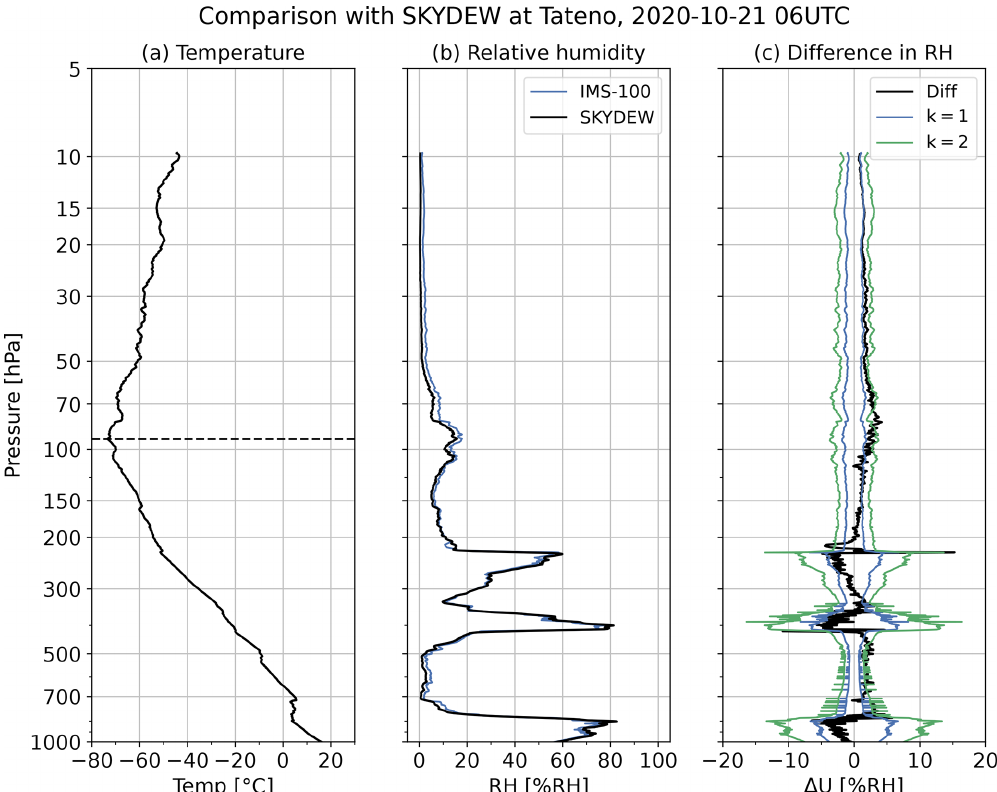
Figure 33. Comparison of RH profiles between iMS-100-GDP and SKYDEW at 06:00UTC (15:00LT) on 21 October 2020. (a) Air temper- ature from iMS-100. The dashed line shows the tropopause height (92.2hPa; 16983.0m in geopotential height). (b) RH from both. The blue and black lines show iMS-100-GDP and SKYDEW, respectively. SKYDEW RH is calculated from SKYDEW frost/dew point temperature and iMS-100 air temperature. (c) RH difference in iMS-100 from SKYDEW (black) and RH uncertainty for iMS-100-GDP (blue/green for k = 1 and 2,